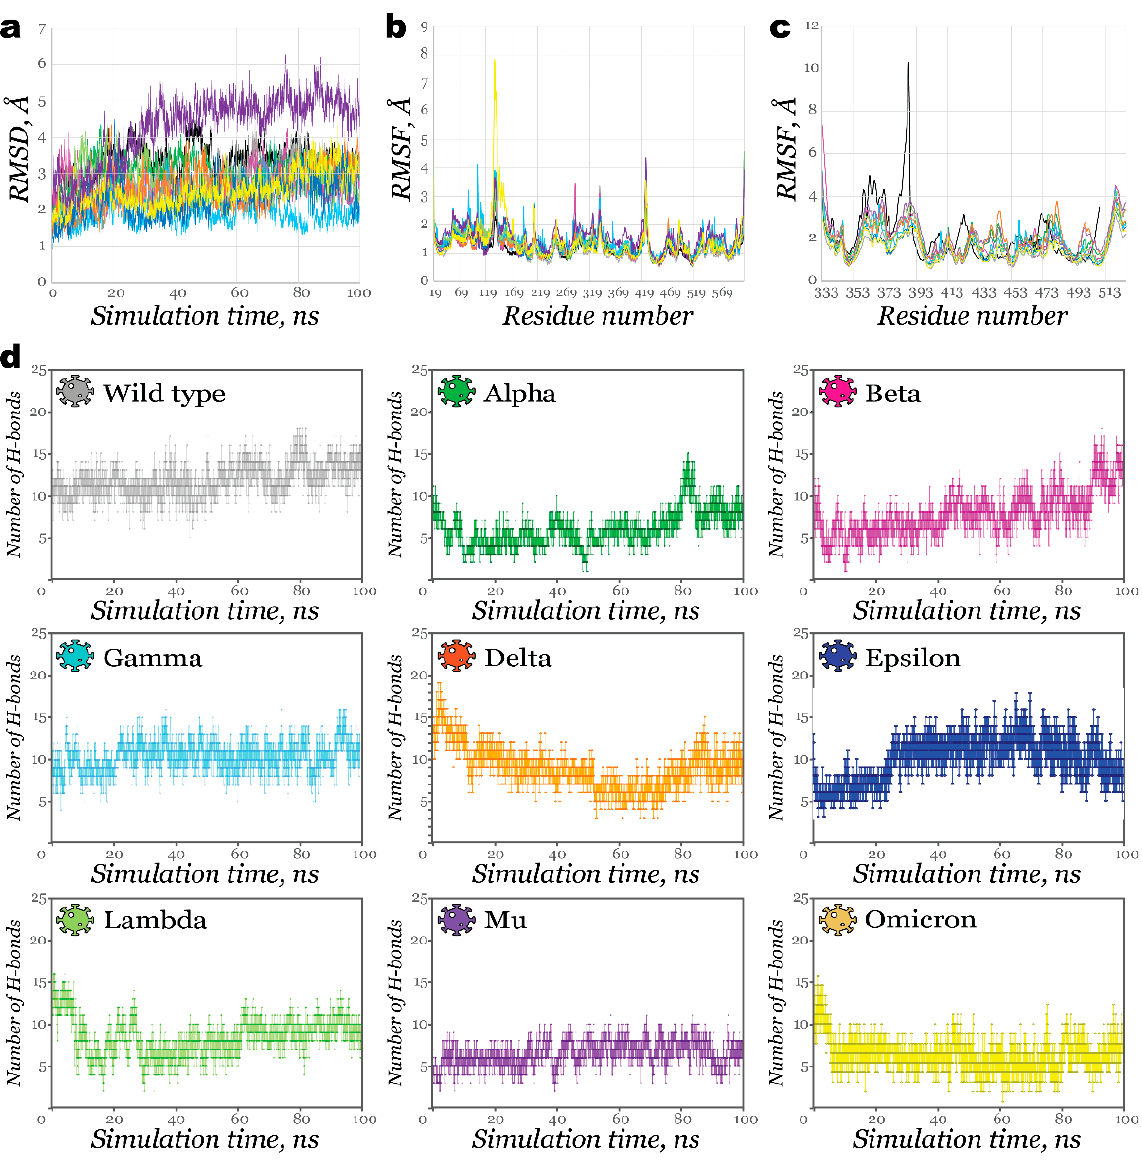
Figure 4. Results of 100 ns MD simulation for RBDACE2 complexes: ( a )—RMSD of complexes (lines are colored based on the variant, black line illustrates RMSD of SARS-CoV RBDACE2 complex); ( b )—RMSF of ACE2; ( c )—RMSF of RBD; ( d )—Number of hydrogen bonds retained during 100 ns MD simulation.